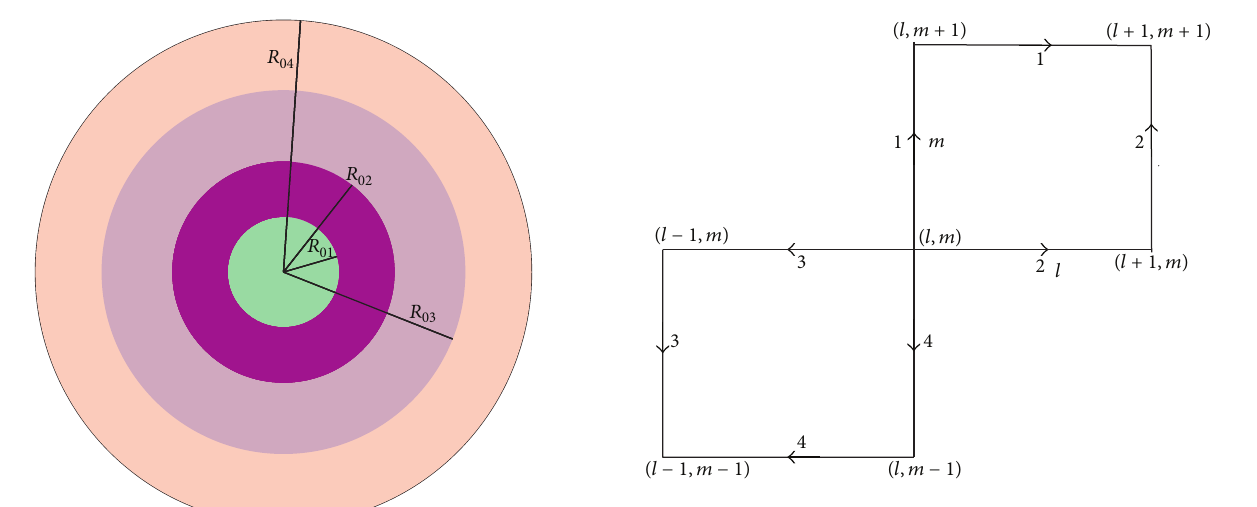
Figure 2: Connecting paths between the states (𝑙, 𝑚) and (𝑙±1, 𝑚± 1)